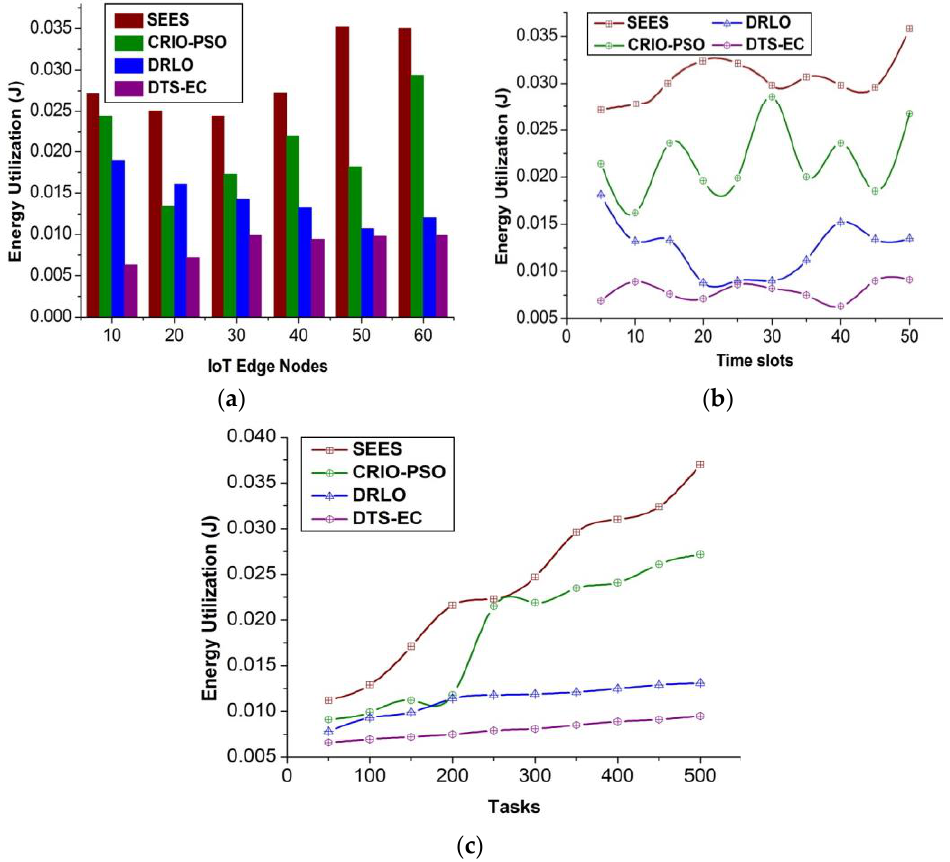
Figure 5. Energy utilization comparisons for ( a ) IoT edge nodes, ( b ) time slots, and ( c ) tasks.